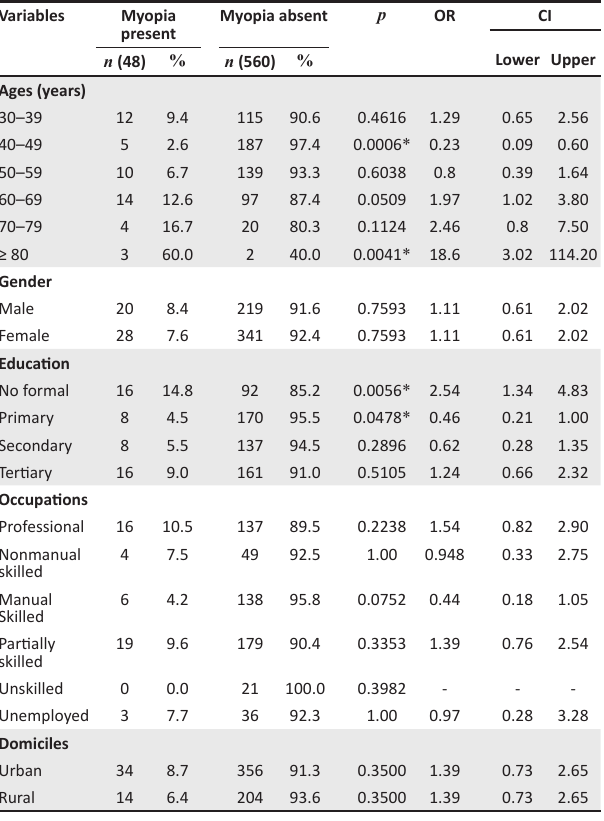
Prevalence of refractive error TABLE 6: Associations between sociodemographic factors and myopia.